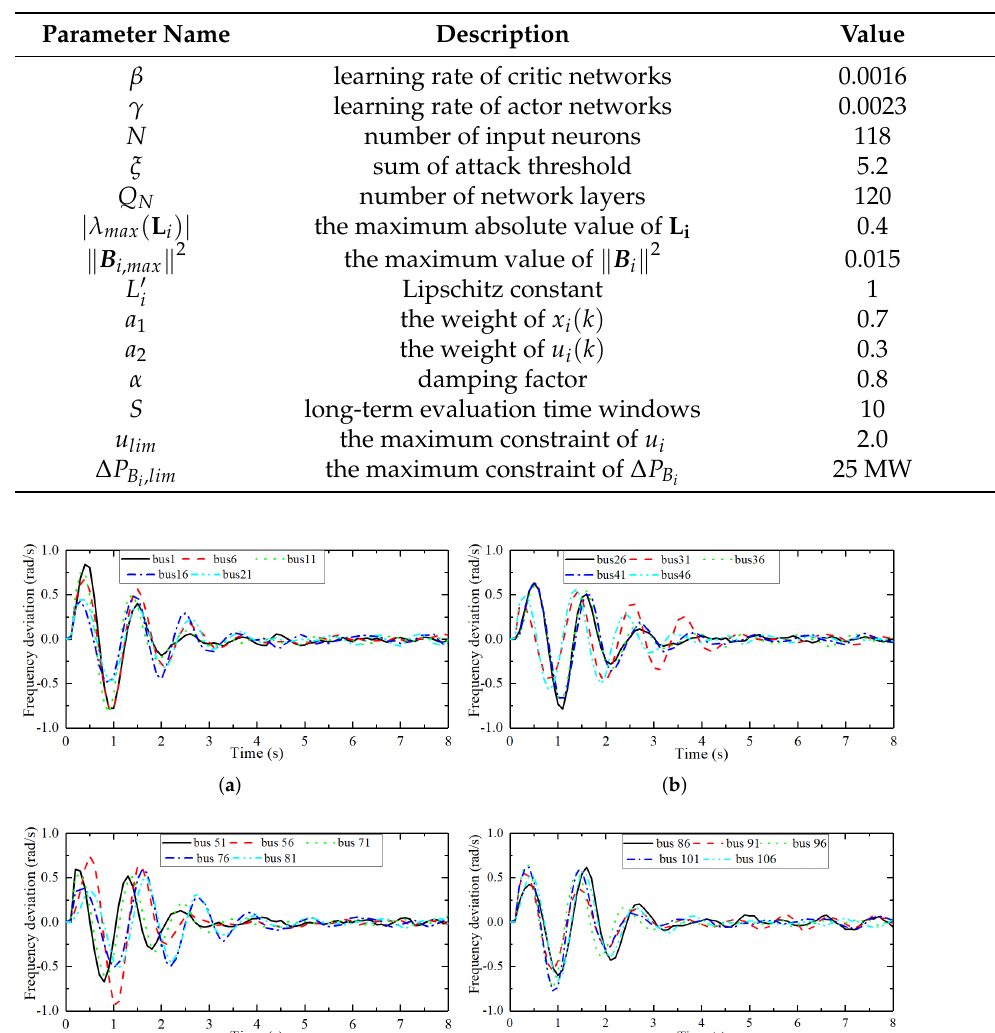
Table 5. Learning parameters of the IEEE118 bus testing system.